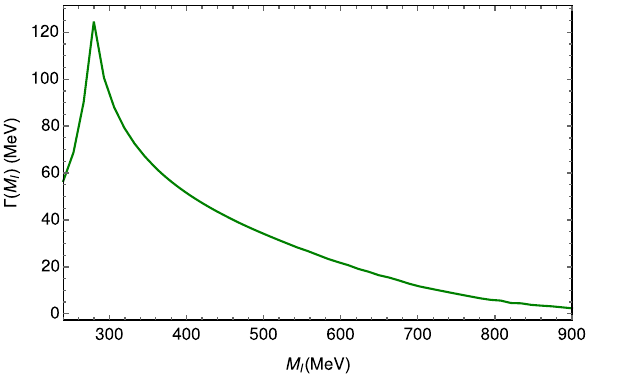
→ π + σ) from Eq. (23) as a function of M Fig. 3 (cid:8)( a + 1 = 1255 MeV M a 1